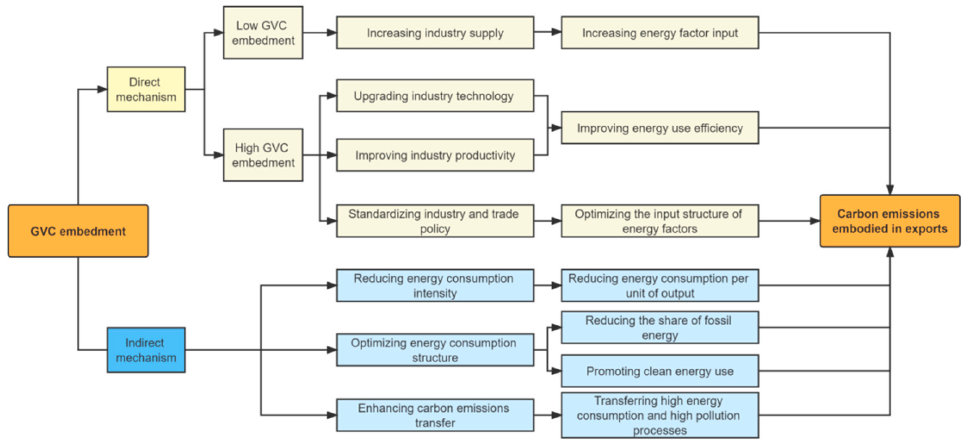
Figure 1. Theoretical mechanism of the impact of GVC embedment on the carbon emissions embodied in exports.